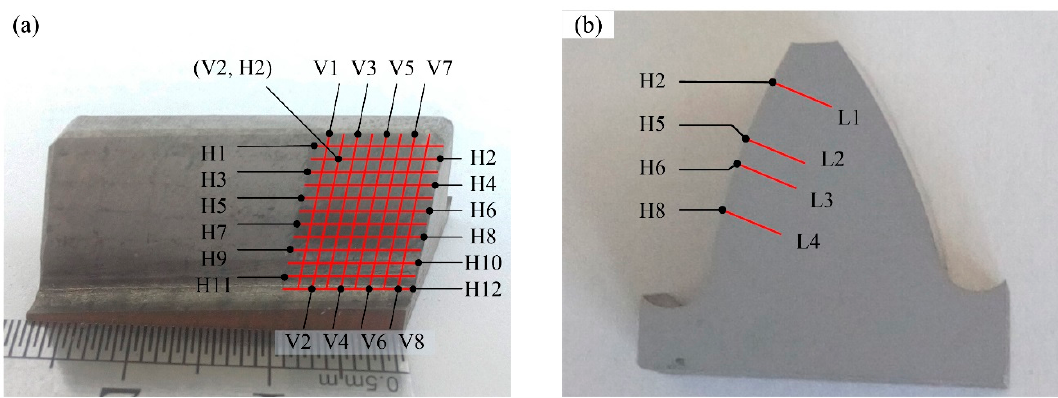
Figure 6. ( a ) Meshing method of tooth flank meshing zone: (V2, H2) illustrates the representation method of the intersecting points. For example, (V2, H2) is the intersecting point of line V2 and line H2. ( b ) Position distribution of hardness measurement (L1, 2, 3, and 4 denote lines along the inner normal direction of points (V2, H4), (V2, H5), (V2, H6), and (V2, H8), respectively.